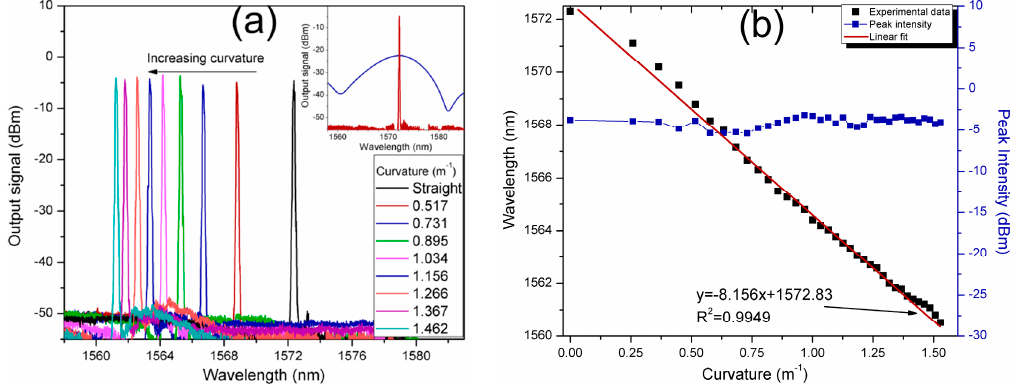
Figure 7. ( a ) The output signal of the laser sensor based on the SMDS in-fiber structure under curvature variations; ( b ) laser peak wavelength and peak intensity as a function of the curvature.